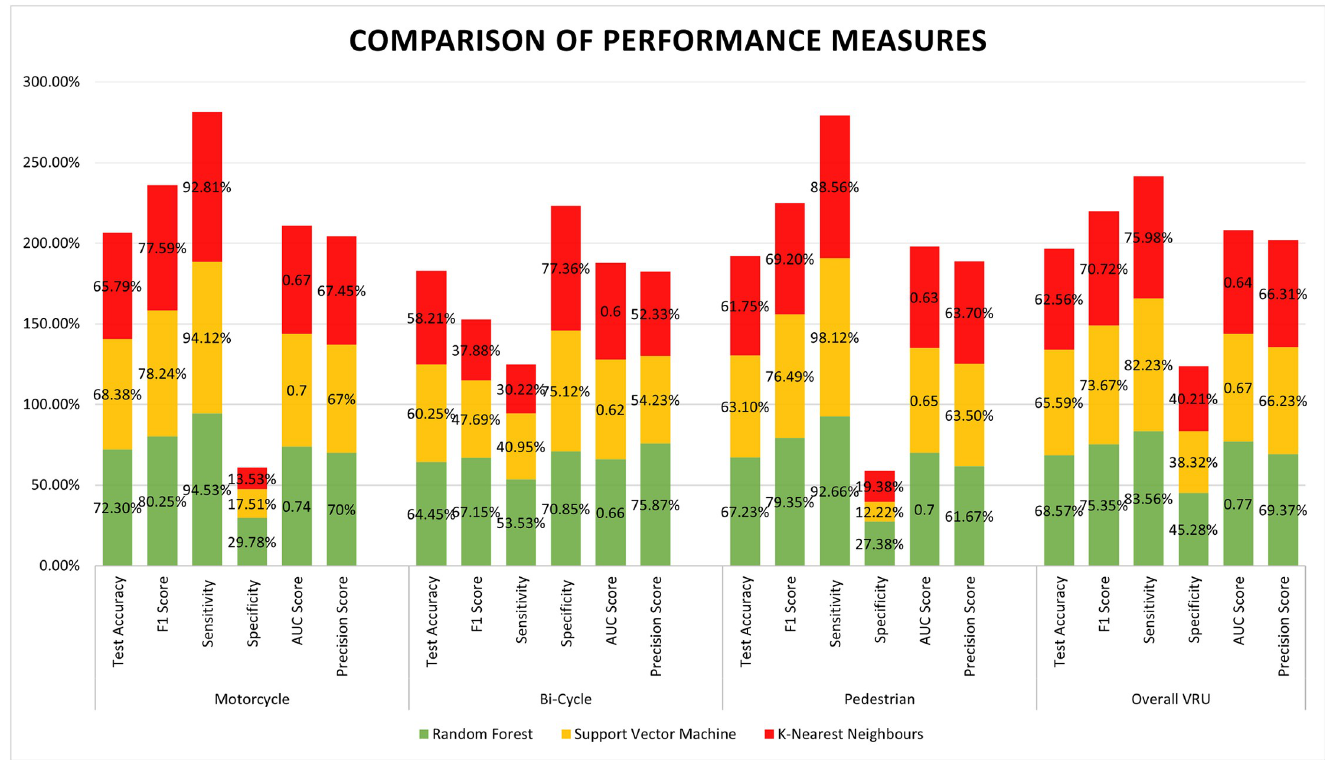
Fig 2. Comparison performance measures of classifiers for different VRU